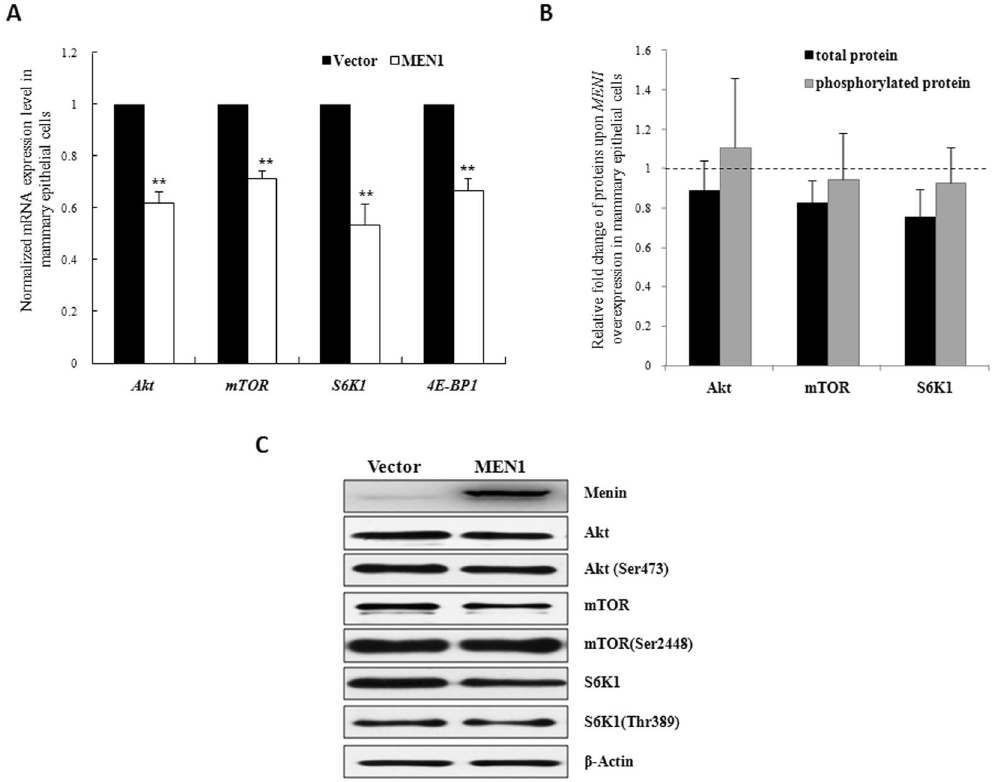
Figure 2. MEN1 overexpression suppressed the expression of genes that regulate milk protein synthesis in mammary epithelial cells. The expression levels of factors involved in the PI3K/Akt/mTOR pathway (Akt, mTOR, S6K1 and 4E-BP1) that are associated with milk protein synthesis were assessed at the mRNA (( A ) n = 3) and total protein (( B ) n = 3) levels in MAC-T cells 24 h after transfection with the empty vector (Vector) or the MEN1 expression plasmid (MEN1). The phosphorylation levels of Akt at Ser473, mTOR at Ser2448 and S6K1 at Thr389 were detected simultaneously. The immunoblotting detection of the total and phosphorylated 4E-BP1 at Thr37/46 using primary antibodies purchased from Abcam (Cat No. ab2606) and Cell Signaling Technology (Cat No. 2855) did not yield clear and specific bands (data not shown). The data are shown as the relative expression levels normalized to the internal control, β -actin. * P < 0.05, ** P < 0.01. The horizontal dashed line represents the normalized level of their corresponding controls. Representative WB images of the expression of Menin, Akt, Akt phosphorylated at Ser473, mTOR, mTOR phosphorylated at Ser2448, S6K1 and S6K1 phosphorylated at Thr389 are shown in ( C ). PI3K, phosphatidylinositol-3-kinase; Akt, also known as protein kinase B; Akt (Ser473), Akt phosplorylated at Ser473; mTOR, mammalian target of rapamycin; mTOR (Ser2448), mTOR phosplorylated at Ser2448; S6K1, p70 ribosomal protein S6 kinase-1; S6K1 (Thr389), S6K1 phosplorylated at Thr389; 4E-BP1, eukaryotic initiation factor 4E (eIF4E)-binding protein